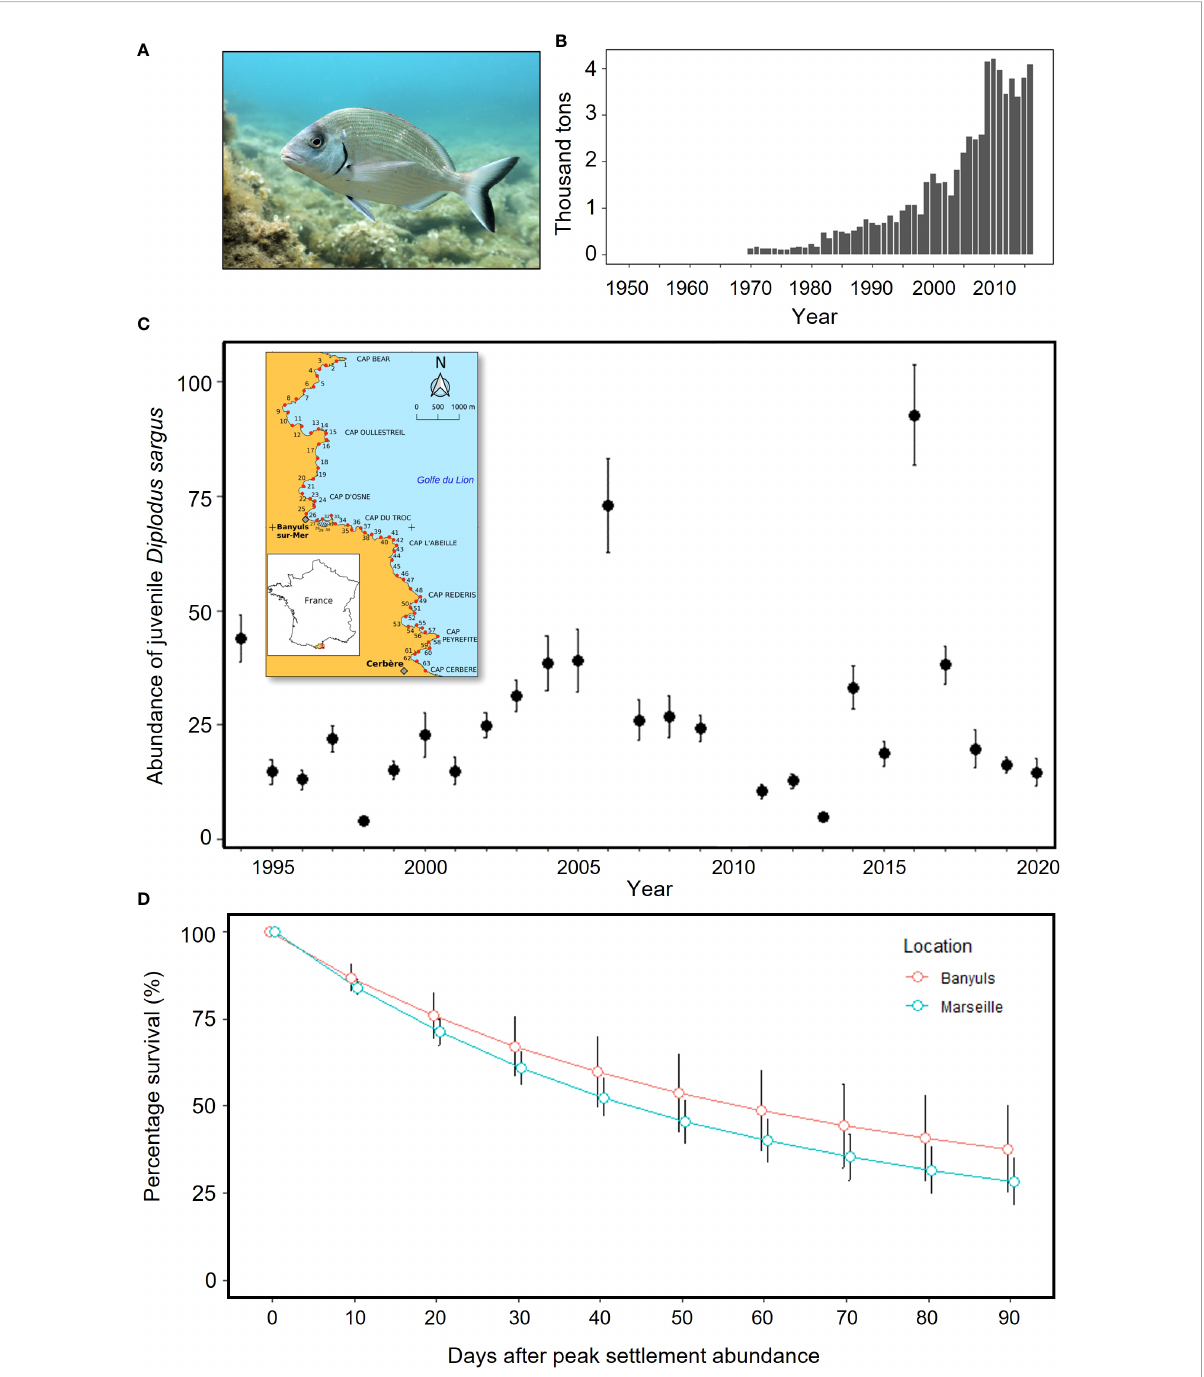
FIGURE 1 (A) Adult white seabream Diplodus sargus; photo: © Virginie Hartmann; (B) FAO global capture production estimates of D sargus (FAO, 2021); (C) local mean abundance ± SE of juvenile D sargus per section surveyed within nursery habitat in French Mediterranean coastline (see inset map with numbered sections); (D) local survival rates (mean ± SE) of D sargus in Banyuls and Marseille, NW Mediterranean, after peak settlement abundance (data replotted from Macpherson et al.,